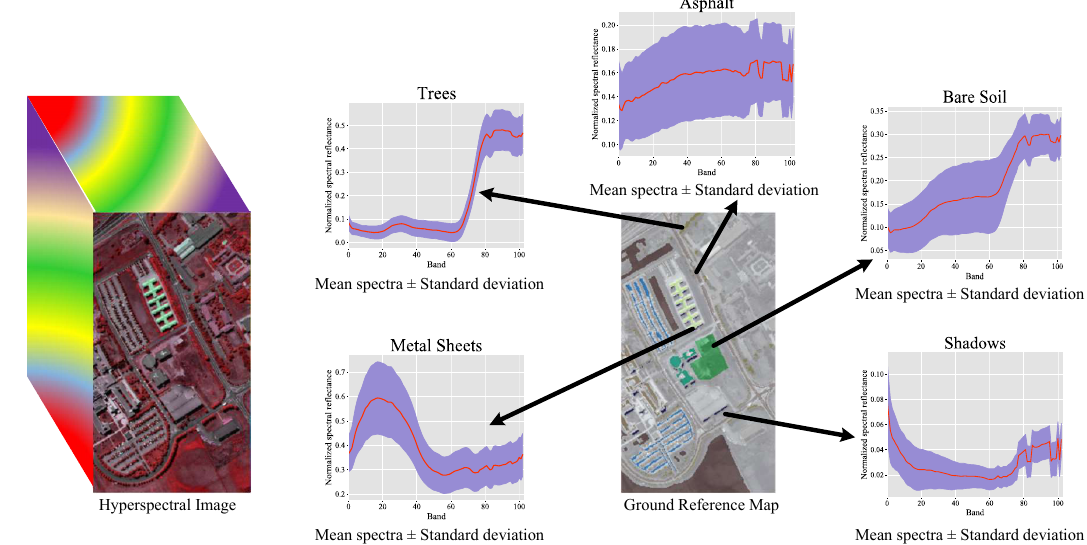
Figure 1. A showcase of a real hyperspectral remote sensing image (University of Pavia dataset). The spectral signals of pixels/samples belonging to five typical land-cover categories are